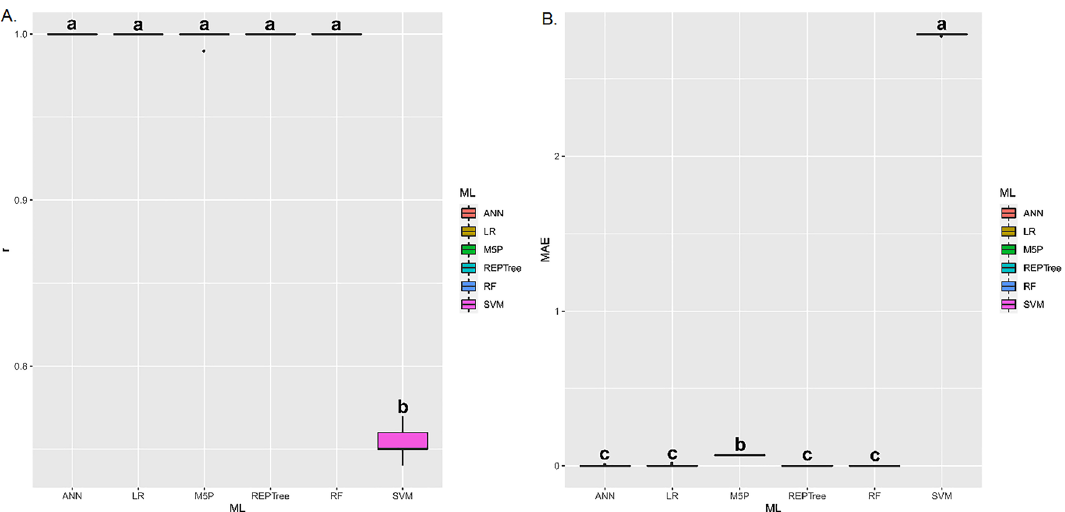
Figure 8. ( A ) Boxplot for Pearson correlation coefficient (r), and ( B ) mean absolute error (MAE) between observed and estimated values of apparent specific mass in corn grains by different machine learning models and inputs. Means followed by equal letters in the same column do not differ by the Scott–Knott test at 5%